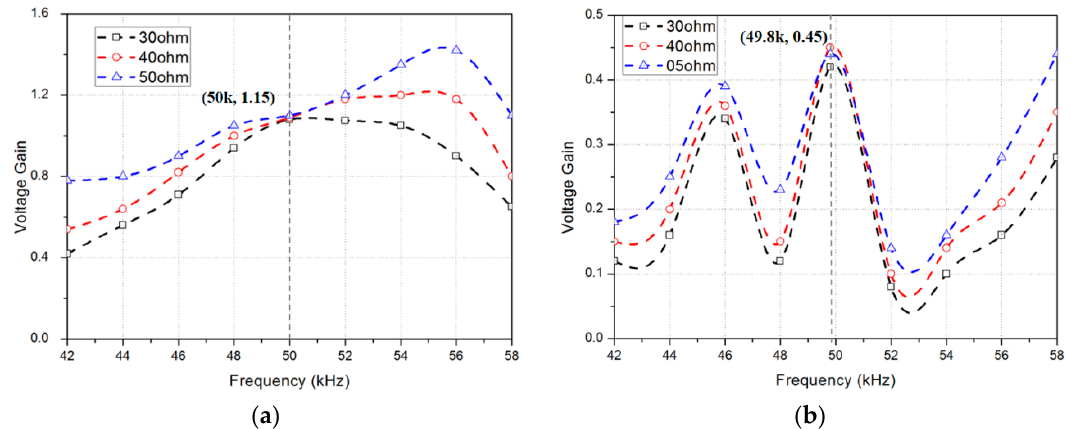
Figure 14. Frequency sweeping curve of system voltage gain in ( a ) Channel 1; ( b ) Channel 2.